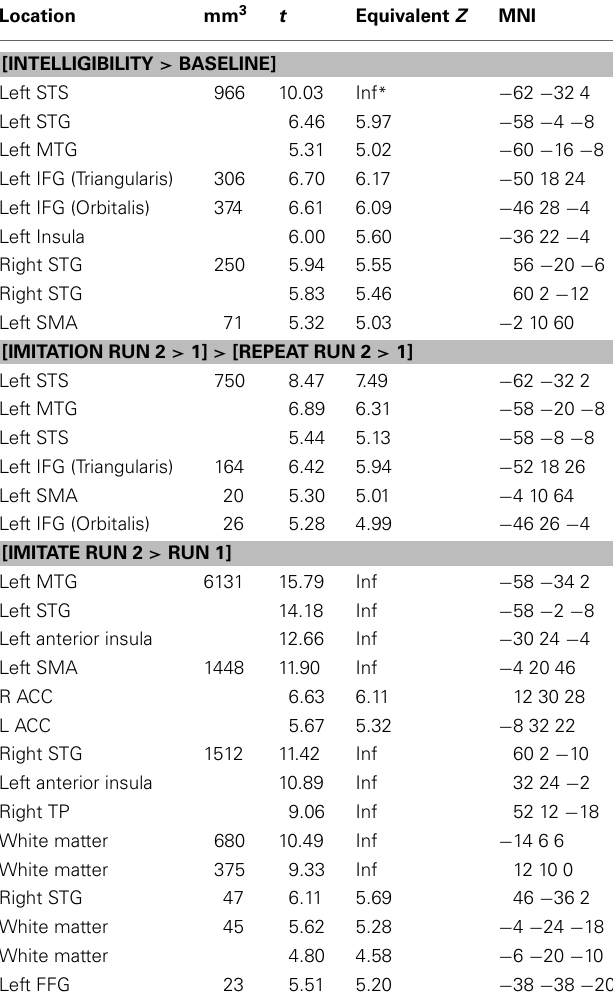
Table 2 | Activation for peaks separated by at least 8mm for the whole-brain analysis for the contrasts [Intelligibility >